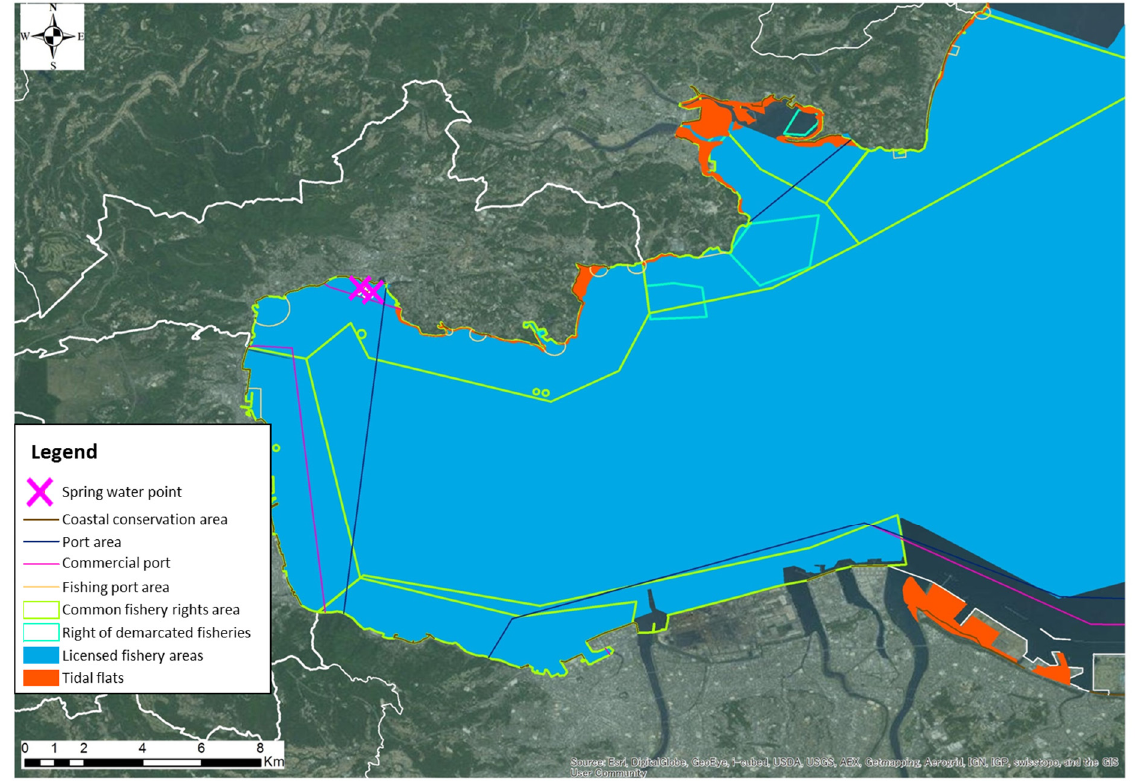
Figure A1. Beppu Bay—Multiple overlay map. Source: